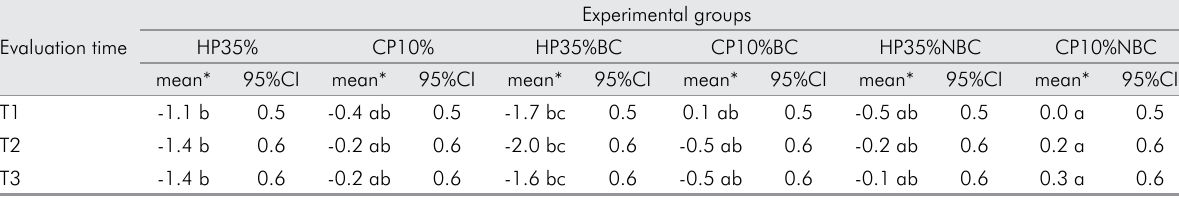
Table 4. Means and Confidence intervals (95%CI) for ∆a for each experimental group at all evaluation times. Evaluation time